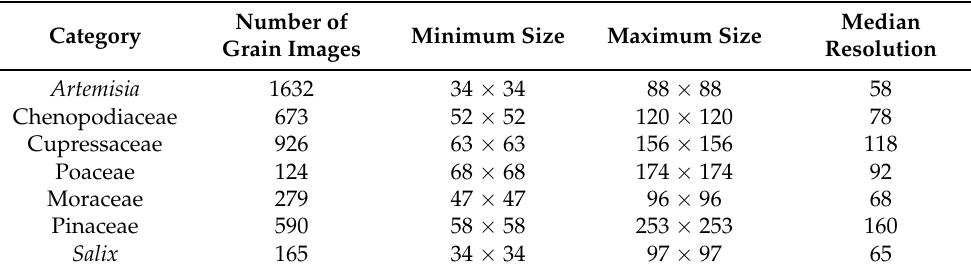
Table 2. The information of different categories in the original dataset, including resolution range, number of samples and median